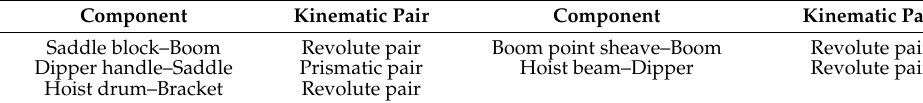
Figure 9. Movement pair settings. Table 4. Kinematic pair constraints.